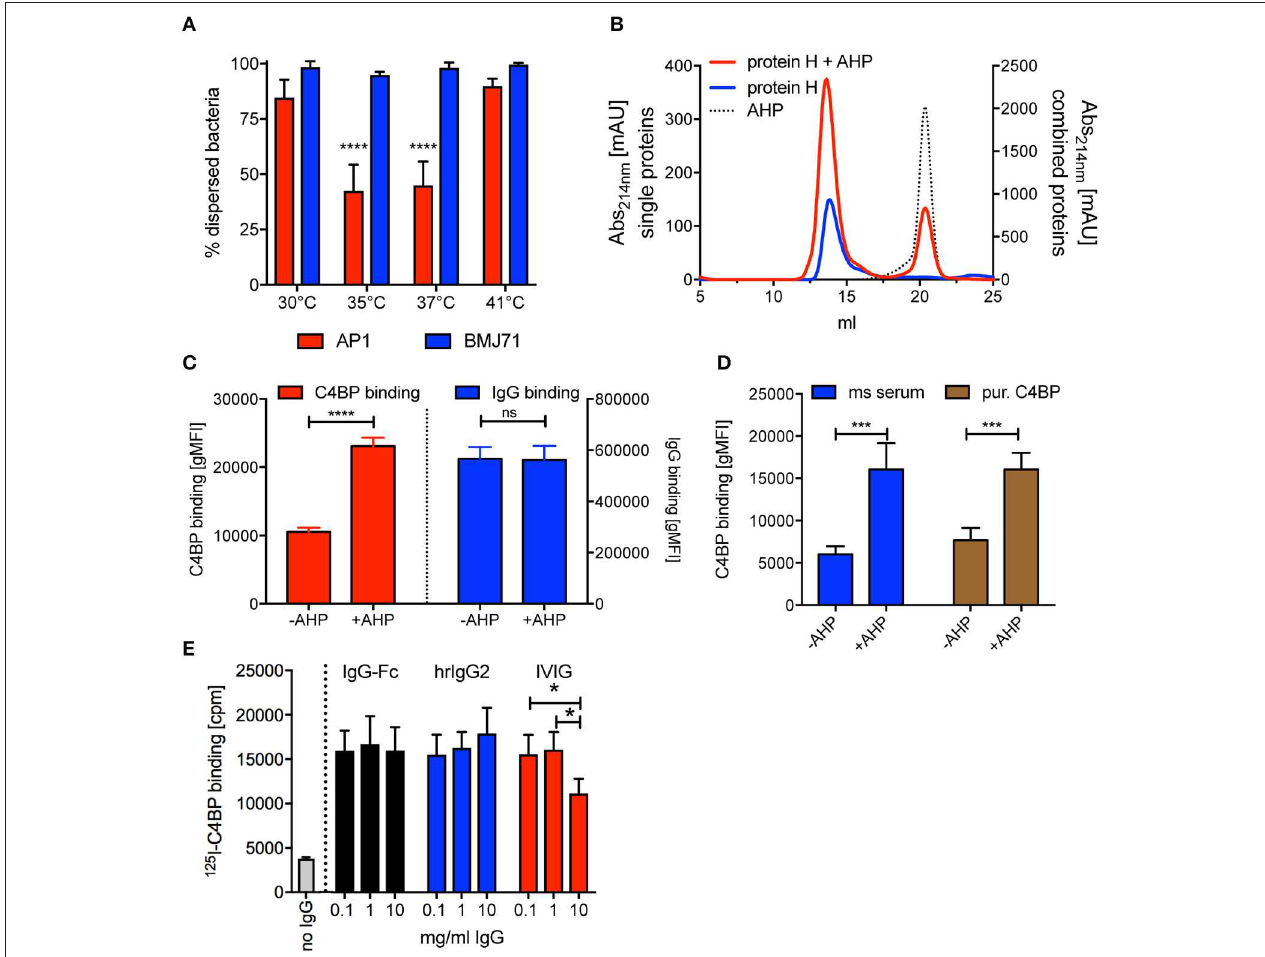
FIGURE 6 | AHP does not disrupt dimers formed by purified soluble Protein H but increases C4BP binding to intact bacteria. (A) S. pyogenes AP1 grown at different temperatures showed aggregation at 35 ◦ C and 37 ◦ C. Bacterial dispersion is significantly decreased for AP1 (red bars) at 35 ◦ C compared with 30 ◦ C and 41 ◦ C as well as at 37 ◦ C compared with 30 ◦ C and 41 ◦ C. Isogenic mutant BMJ71 lacking Protein H (blue bars) shows similar absorption at all temperatures and does not aggregate. (B) SEC analysis using a Superose 6 10/30 column was performed on 10 nmol Protein H in the presence or absence of 100 nmol of a dimer inhibiting peptide (AHP). AHP does not prevent dimerization of Protein H. (C) AHP (100 nmol) increased C4BP binding to 5*10 5 S. pyogenes significantly without altering IgG binding levels. (D) C4BP binding to S. pyogenes is increased in the presence of 100 nmol AHP both in mouse (ms) serum and for purified C4BP. (E) Presence